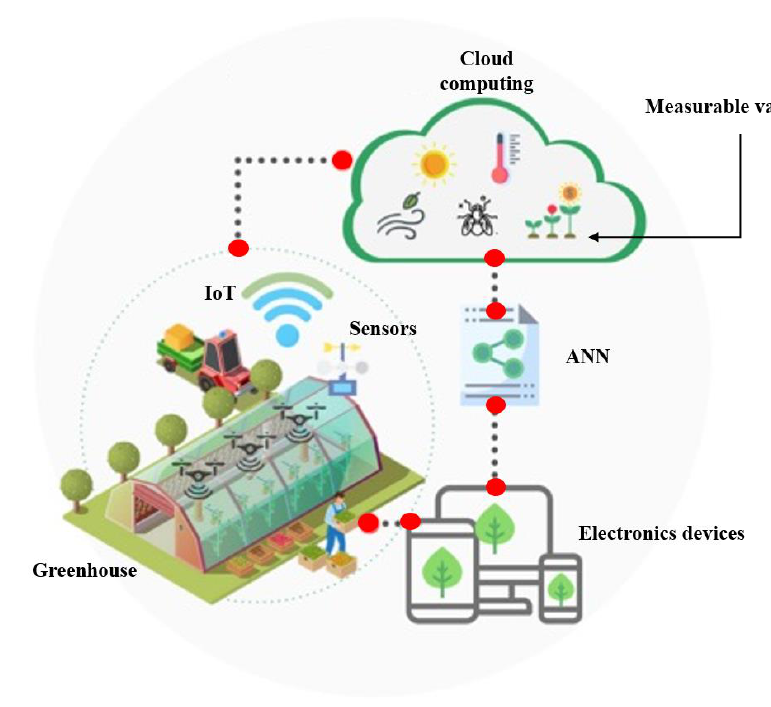
Figure 6. Agriculture 4.0 applied in a greenhouse.